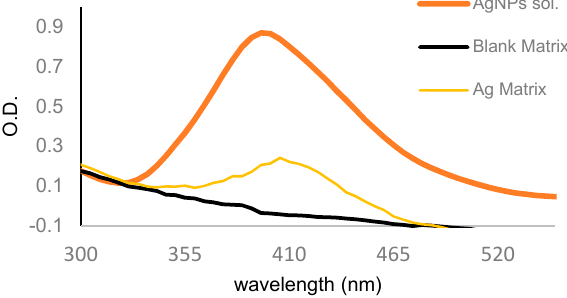
Figure 4. UV-vis absorption spectrum for the 30:70 SilverSil xerogel, blank matrix and silver nanoparticles.